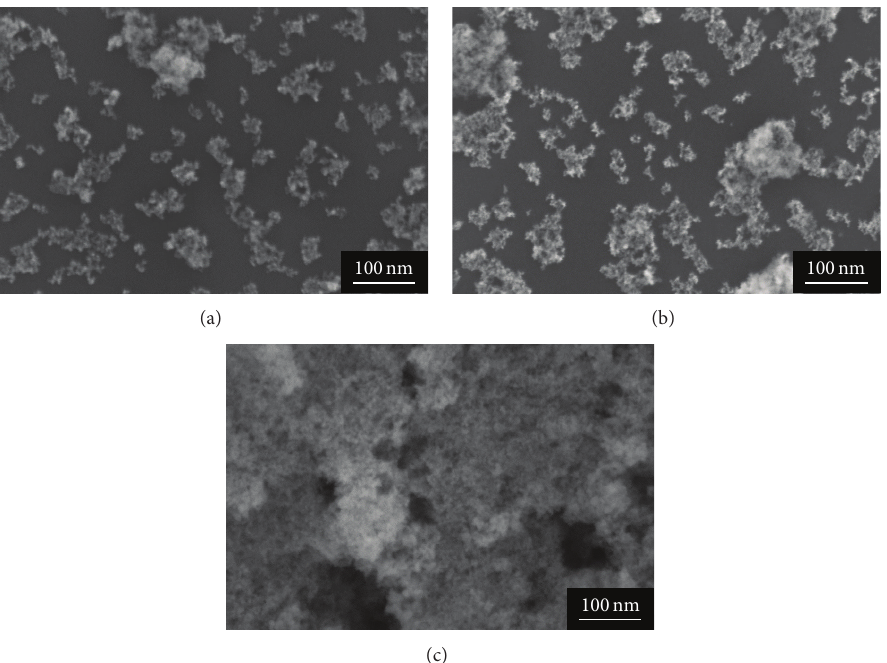
Figure 1: Morphology of the as-prepared diamond layers on D263T glass substrate using spin coating with different parameters.